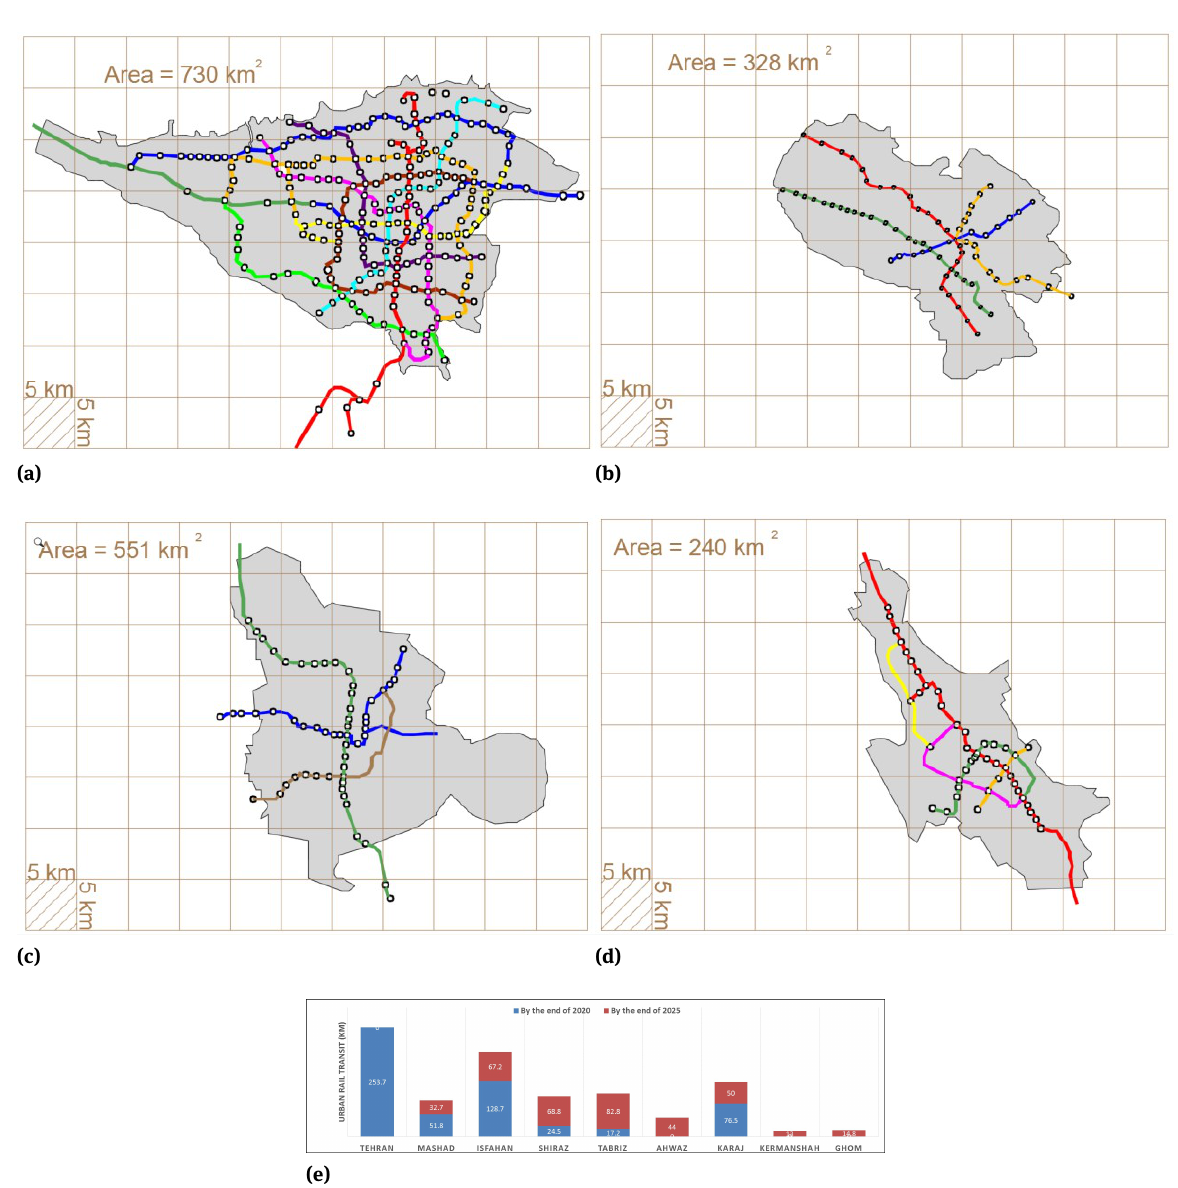
Figure 2: Subway network in different cities of Iran: (a) Tehran, (b) Mashhad, (c) Isfahan, (d) Shiraz and (e) the status of urban rail transport in Iranian